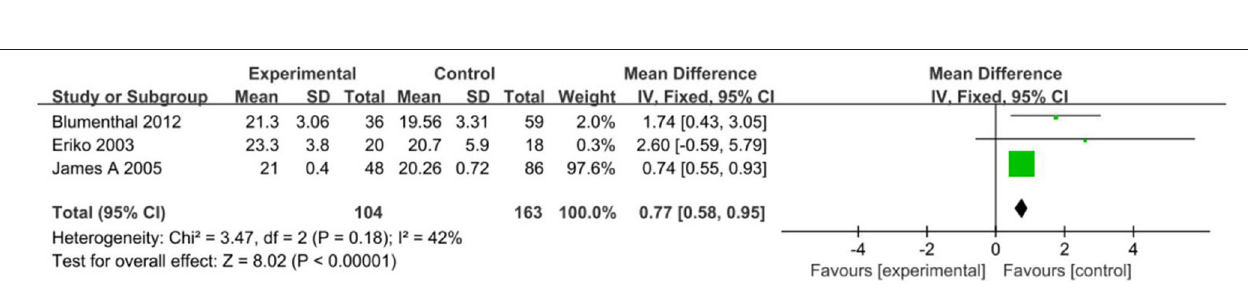
FIGURE 9 | Meta-analysis: peak oxygen uptake with exercise therapy in patients with coronary heart disease.